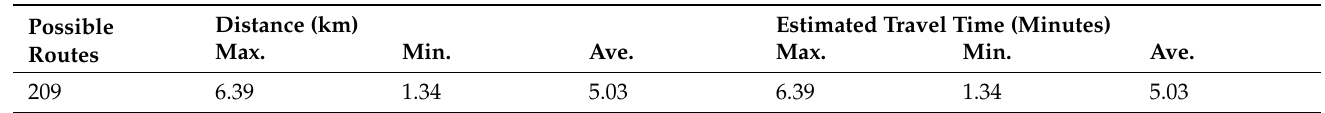
Table 7. Length of the evacuation route and the travel time by vehicle from the isolated area of Jeungpyeong-ri to the nearest shelter.